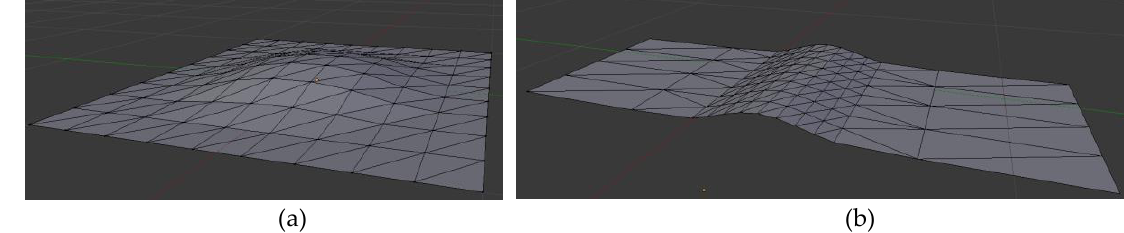
Figure 5. Examples of objects divided into the triangles. ( a ) A sketch of a car roundabout; ( b ) a sketch of a speed bump.